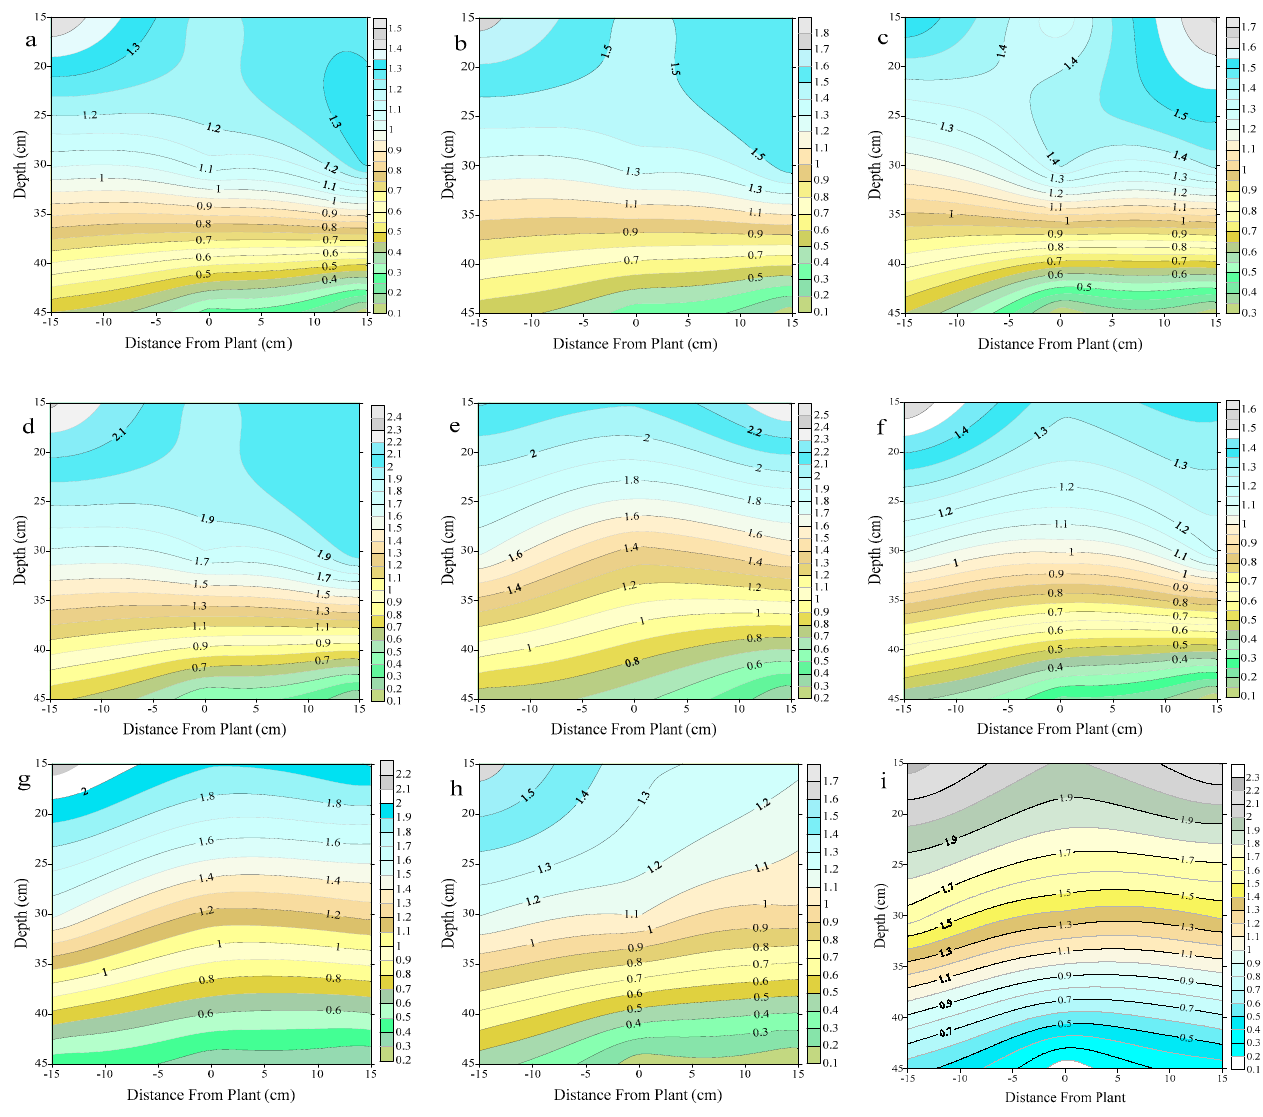
Figure 3. Salinity distribution under regulated deficit irrigation for ( a ) 100%, ( b ) 80%, ( c ) 60%, and ( d ) 40% ETc and under partial root drying for four four stages, full irrigation treatment ( e ), ( f – h ) without biochar and ( g – i ) with biocahr under fresh